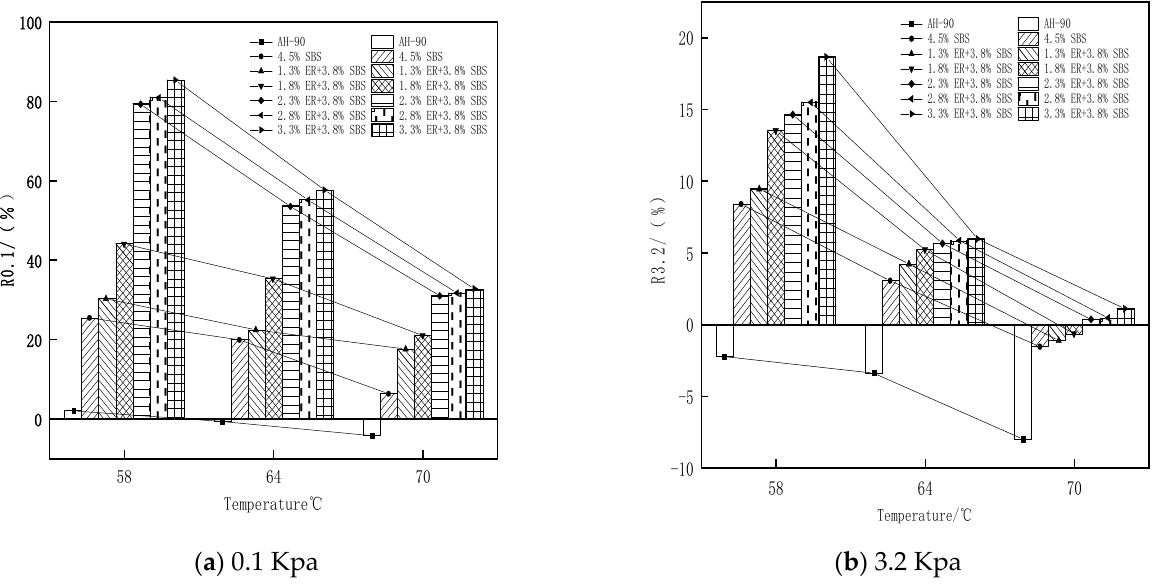
Figure 13. Average strain creep recovery rate of each bitumen with temperature under different stresses.